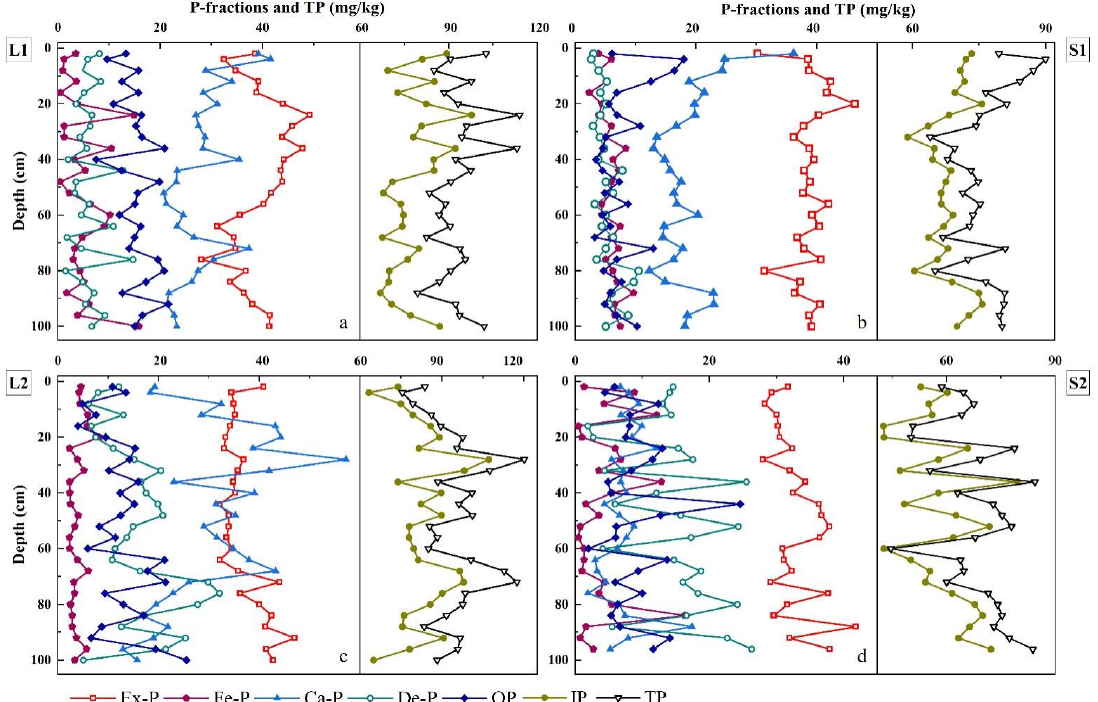
Figure 3. Trends of the Ex-P, Fe-P, Ca-P, De-P and OP concentrations (pictured left of each plot) and details of IP and TP fractions (pictured right of the plots) along the sediment cores. The X-axes represent the concentrations of the sedimentary P species, labels on the Y-axis indicate the depths of the sediment cores.